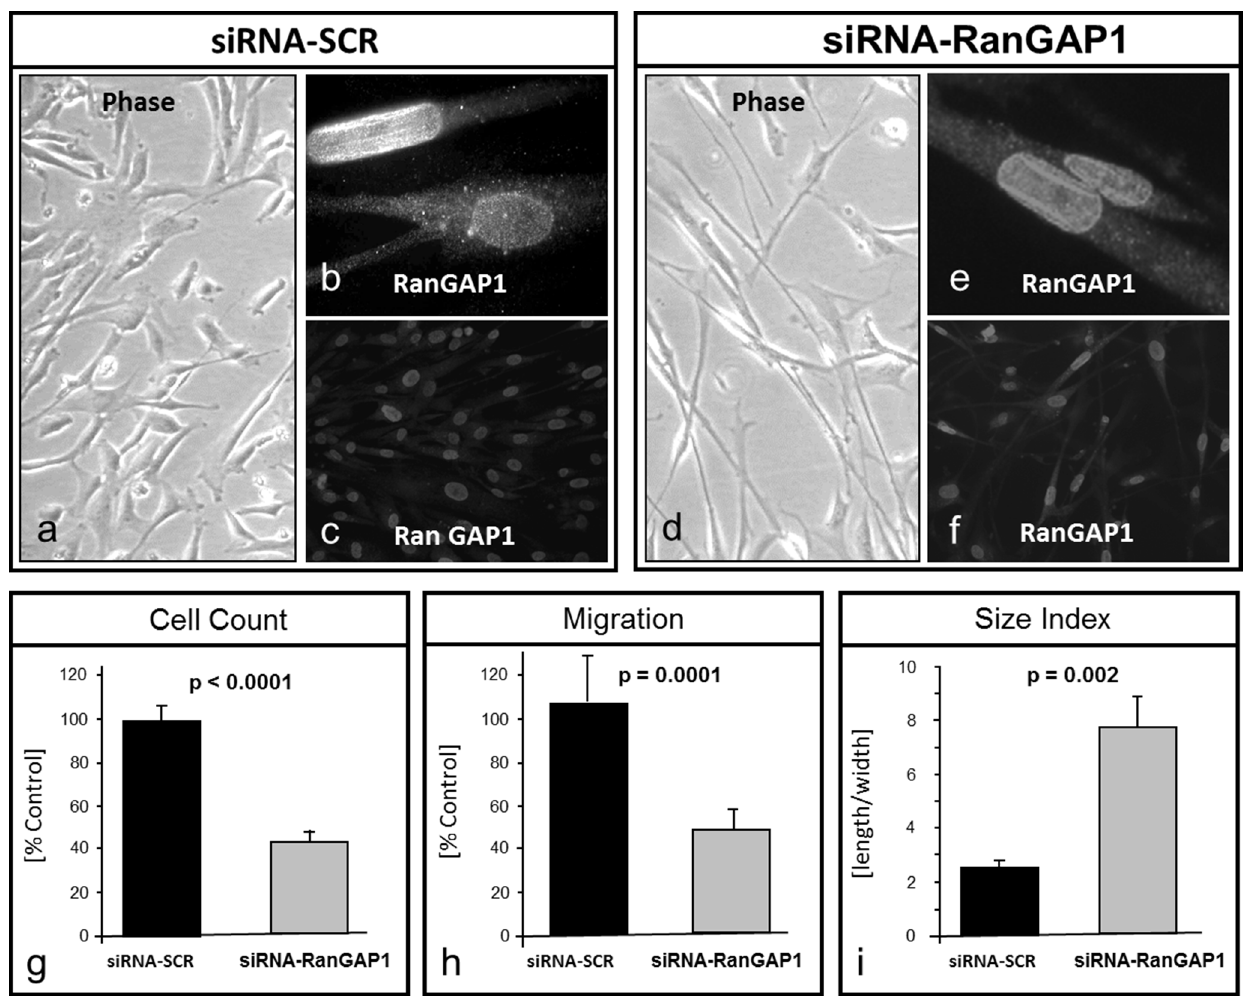
Figure 2. Gene silencing of RanGAP1 by siRNA in CASMC. CASMC fixed and permeabilized with 4% PFA and 0.2% Triton X-100 were subjected to indirect immunofluorescence with an RanGAP1 antibody. CASMC treated with control scrambled siRNA reveal accumulation of RanGAP1 expression at the nuclear rim rather than in the cytosol (a–c). Likewise, siRNA-RanGAP1 mediated gene silenced CASMC show a residual RanGAP1 expression mainly at the nuclear rim (d–f). Gene silencing of RanGAP1 by means of specific siRNA transfection lead to inhibition of proliferation by 57.4 6 4.8% (p , 0.0001) (g). Similarly, mitogen-induced CASMC migration was sharply inhibited by 48 6 9% in RanGAP1 siRNA transfected cells (p=0.0001) (h). Concomitantly, the phenotype of siRNA RanGAP1 treated CASMC showed a significant difference in the cellular size index (length/ width; 7.8 6 2.5 vs. 2.5 6 0.9 p=0.002) (i), indicating a phenotypic change that is consistent with contractile, quiescent CASMC.